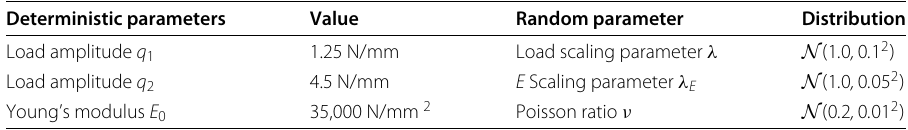
Table 5 Definition of deterministic and random parameters of the 2D cross-section